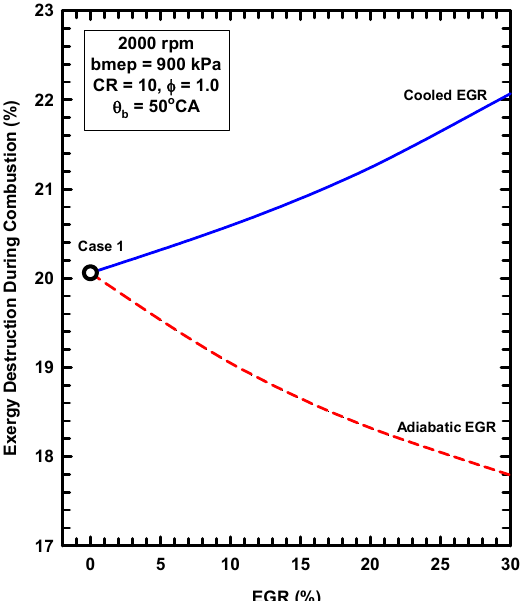
Figure 18. The exergy destruction during combustion as functions of the EGR percentage for the two EGR configurations.